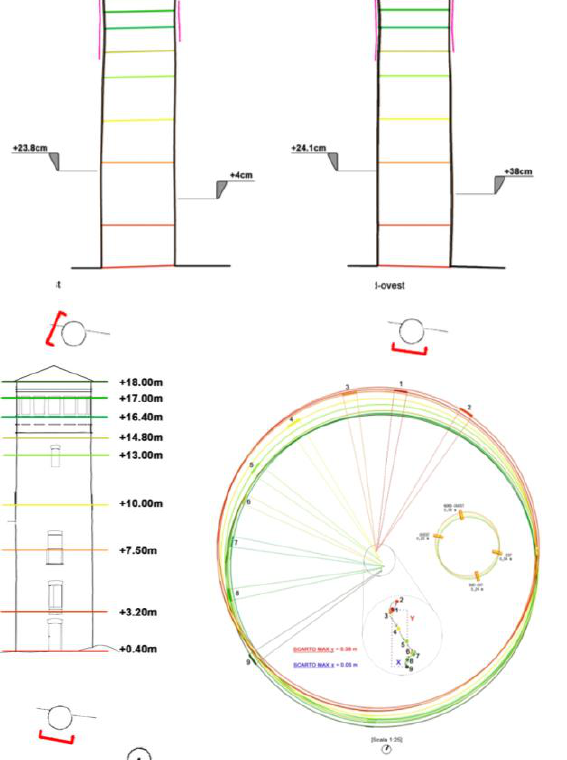
Figure 3. Study of the vertical axe of the tower, and progressive displacement of the cone progressive sections, which have been assumed to date from the construction phase.